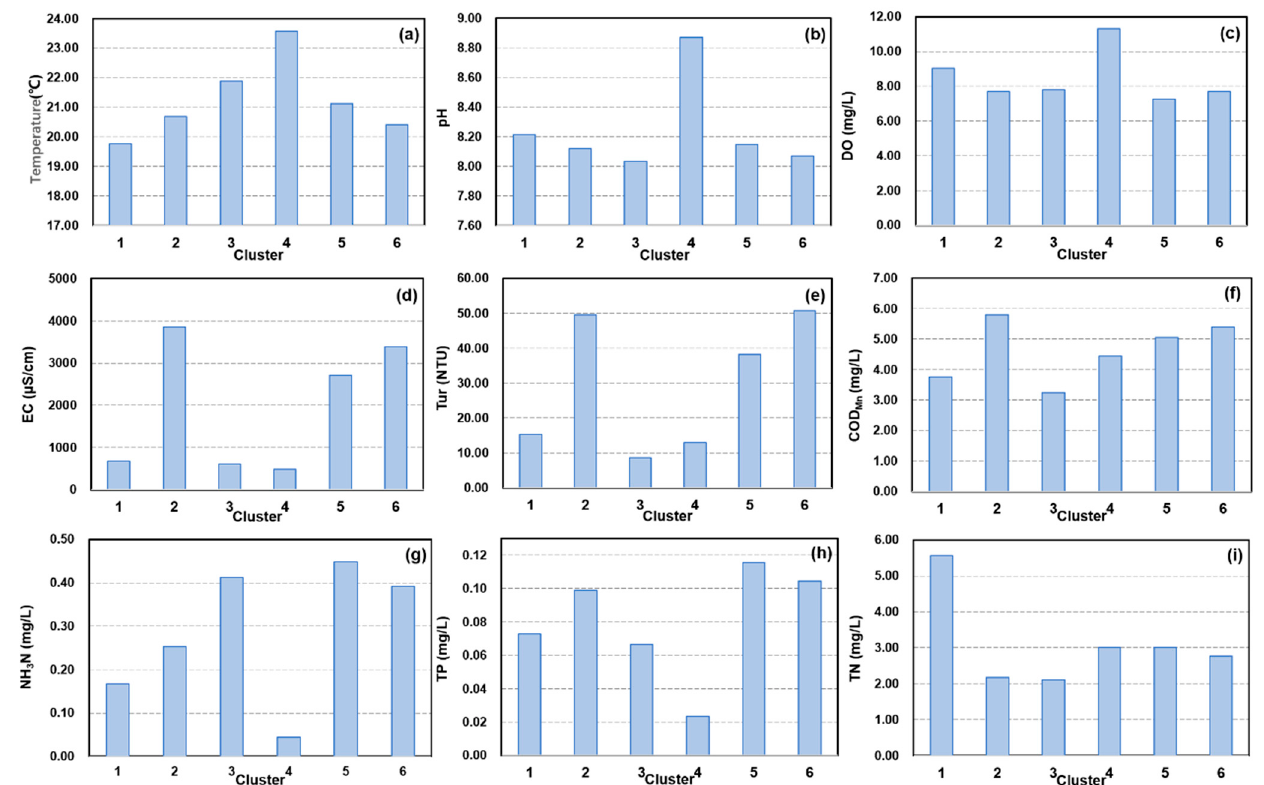
Figure 7. The mean values of the main water quality parameters in the different clusters identified in Tianjin. ( a ) temperature; ( b ) pH; ( c ) DO, dissolved oxygen; ( d ) EC, electrical conductivity, ( e ) Tur, turbidity; ( f ) COD Mn , permanganate index; ( g ) NH 3 N, ammonia nitrogen; ( h ) TP, total phosphorus; ( i ) TN, total nitrogen.